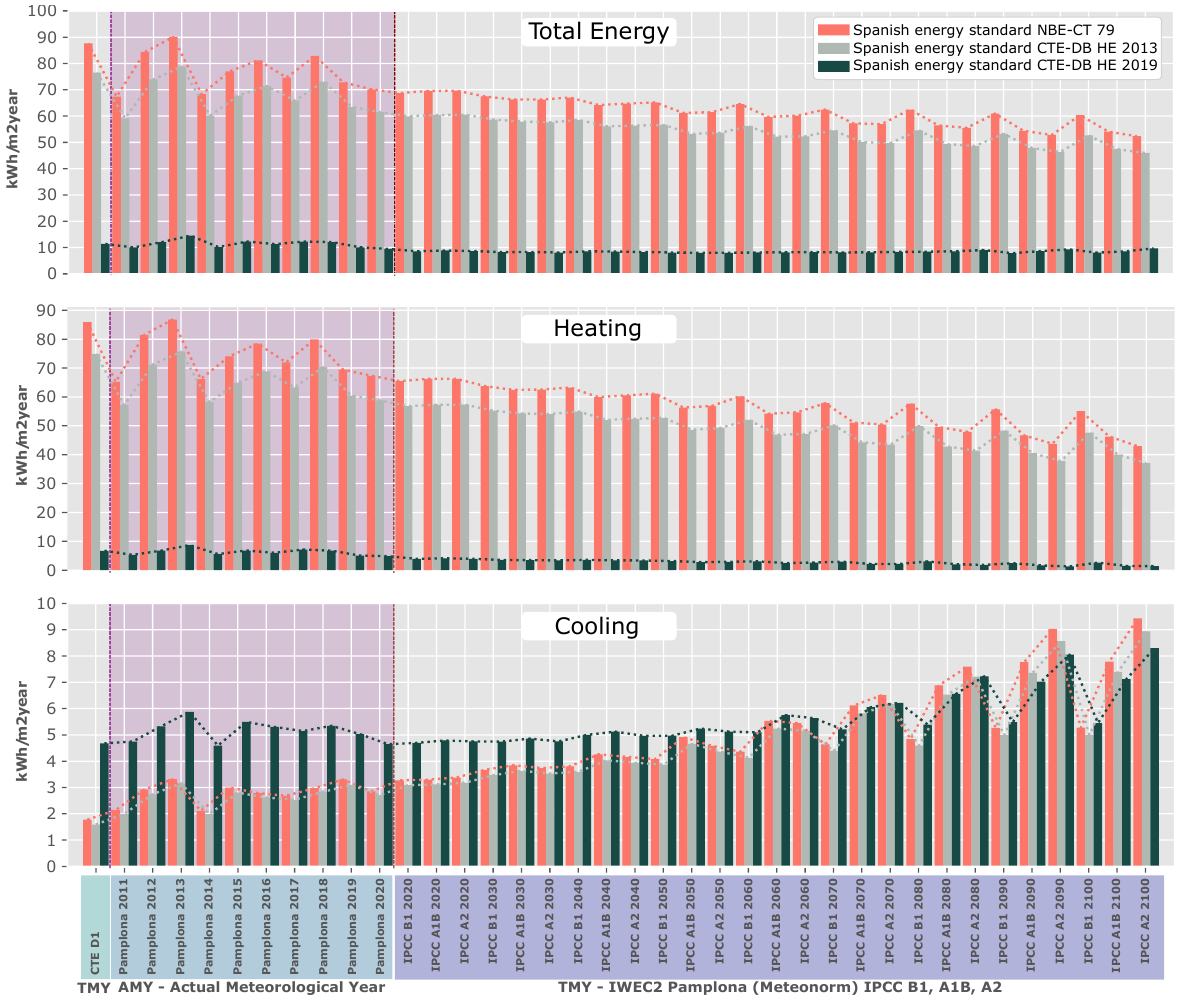
Figure 3. Energy consumption [Total, Heating, Cooling] taking into account, typical meteorological year, actual meteorological year and future weather scenarios